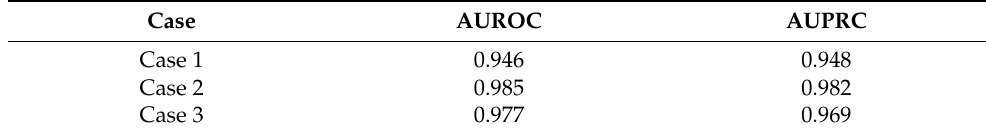
Figure 10. ROC curves of our method under different input conditions.